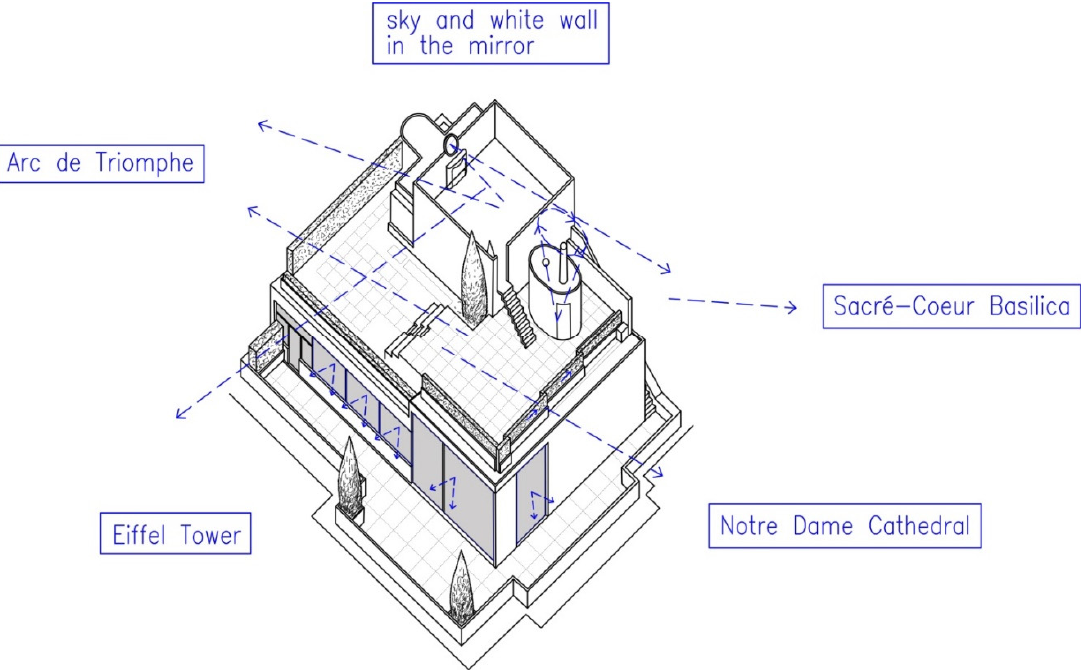
Figure 3. Axonometry—the external view relations on the roof of the Beistegui apartment. Own study 2022.